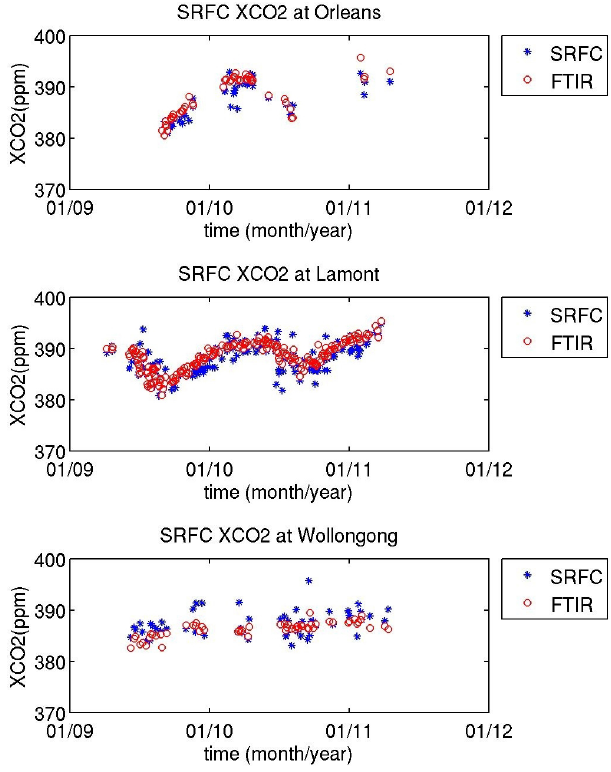
Figure 7. Daily averaged time series of paired OCFC and TCCON FTIR XCO 2 at Orleans (top), Lamont (mid) and Wollongong (bot- tom).